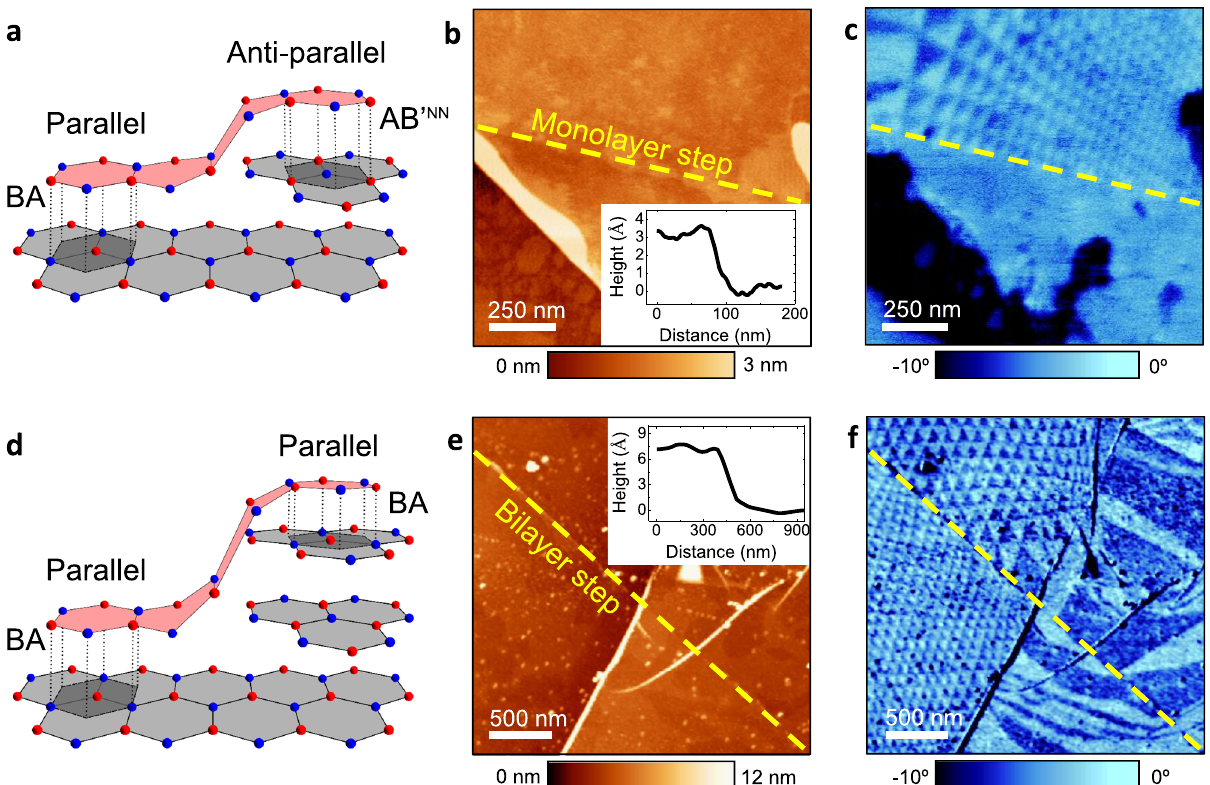
Fig. 2 Effect of mono- and bi-layer terraces on occurrence of charge-polarized domains. a Illustration of hBN alignment over a monolayer terrace in the bottom hBN. The terrace forces an alignment change from parallel (left) to antiparallel (right) at the interface between top hBN (light red) and bottom hBN (light grey; AA ʹ stacking). Dark-grey areas indicate BA and AB ʹ NN stacking. b AFM topography image of a representative sample, showing an hBN bilayer crystal covering a monolayer terrace in the bottom hBN. Inset: height pro fi le across the step. c Corresponding dc-EFM image. The triangular potential modulation is visible only on one side of the step, marked by the yellow dashed lines in b and c . d Schematic as in a but for a bilayer terrace. The terrace in the bottom hBN (AA ʹ stacking) does not in fl uence the parallel alignment of the top hBN. The dark-grey shaded areas indicate BA stacking. e AFM topography image of an hBN crystal covering a bilayer step in the bottom crystal (inset: the step pro fi le). f Corresponding dc-EFM image. The triangular modulation is visible on both sides of the step marked in